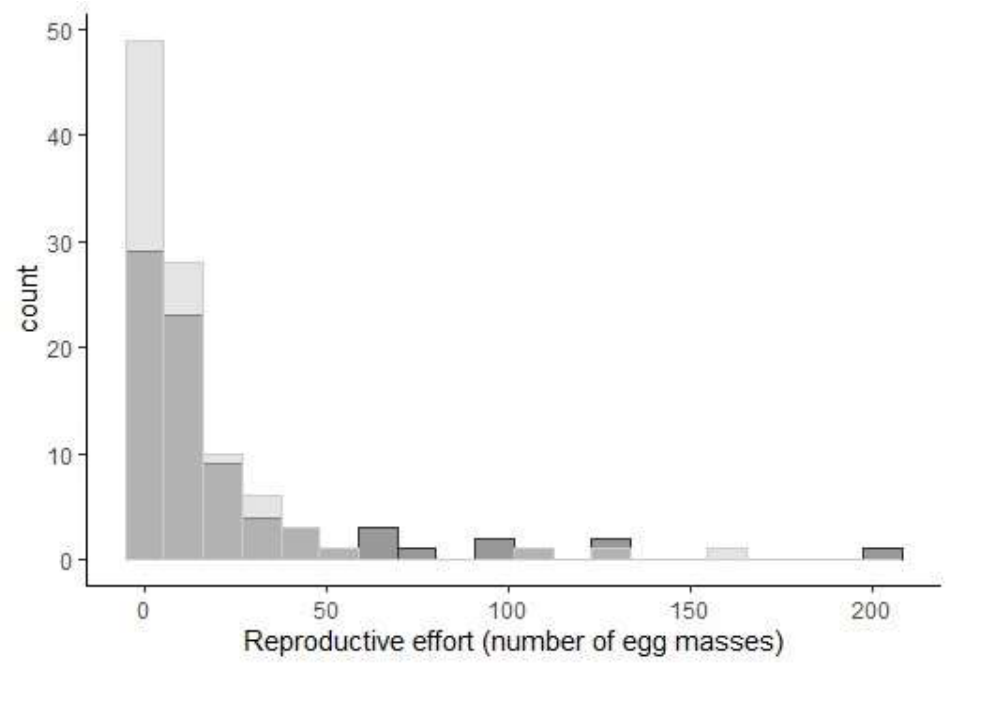
Annex 2: Distribution of the number of egg masses produced at each breeding event per season. Autumn in dark grey and spring in light